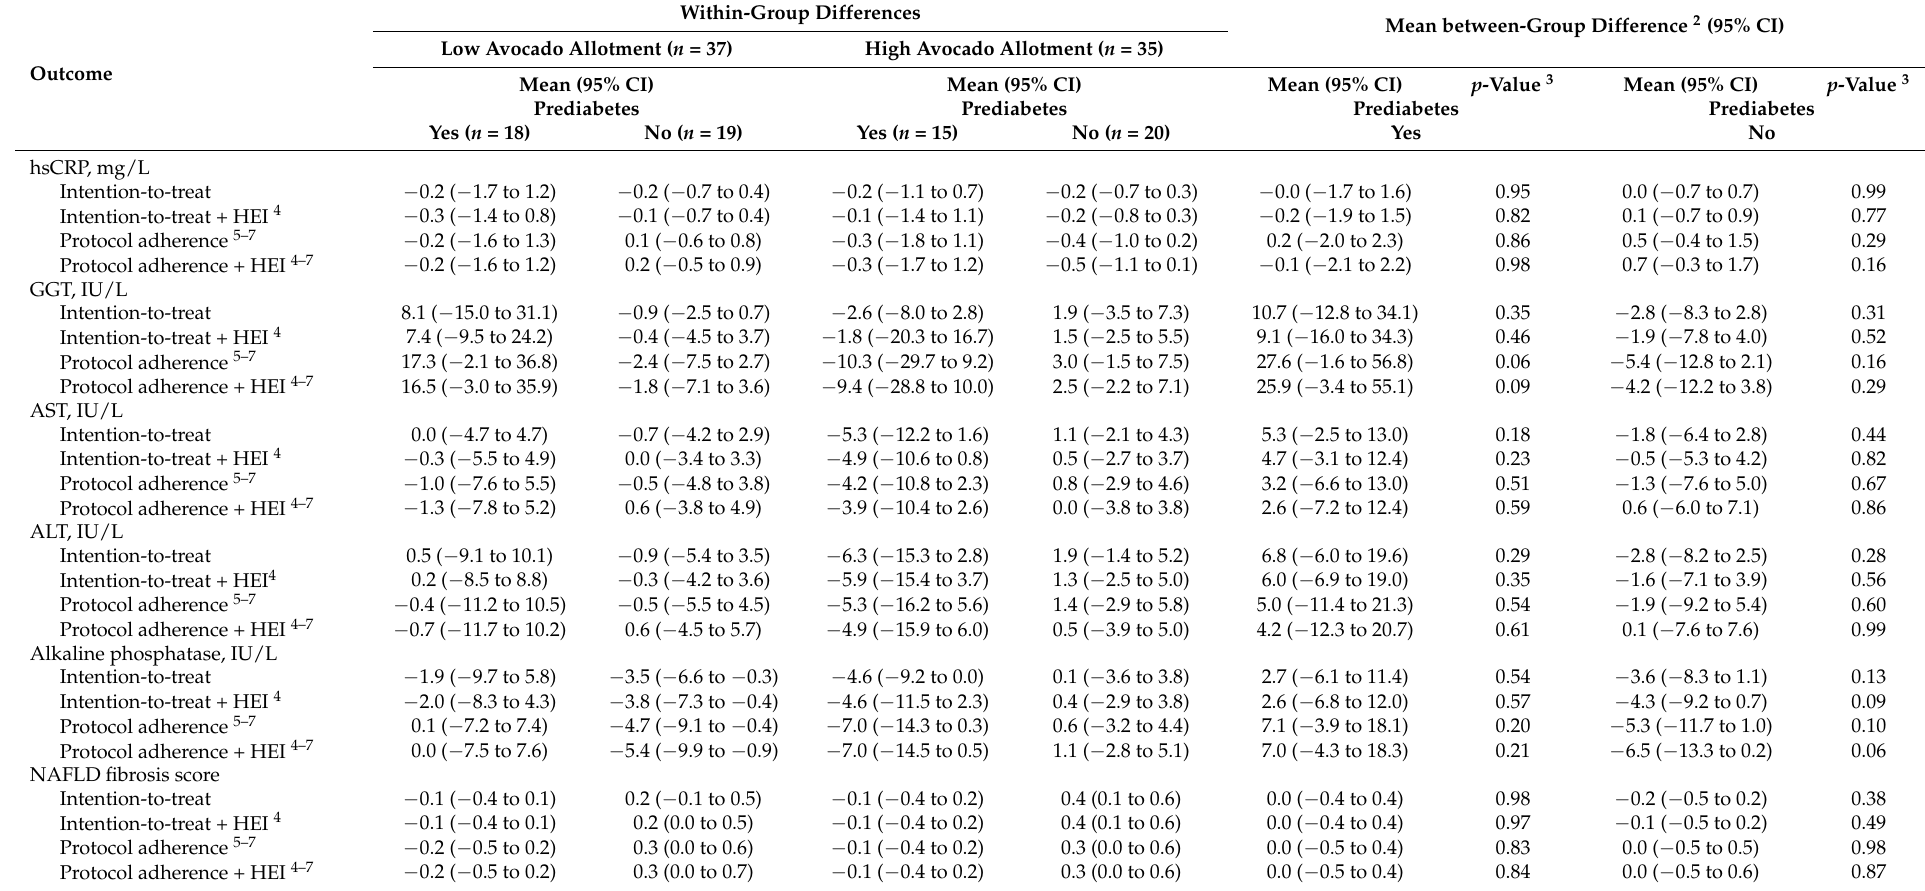
Table 3. Changes in hepatic function outcomes at 6 months, stratified by prediabetes status 1 , per intention-to-treat and protocol adherence